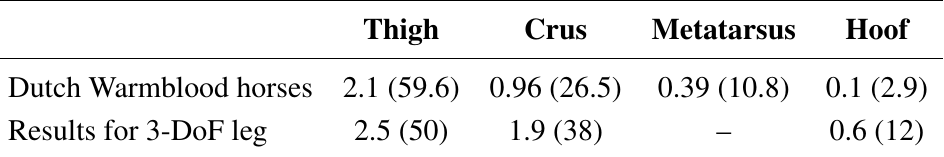
Table 5. Experimental average values of horse leg segment masses expressed in kilograms, extracted from related literature [36], and compared to final results of an iterative search performed through simulation of a 3-DoF leg; percentages of segment mass relative to leg mass are given inside